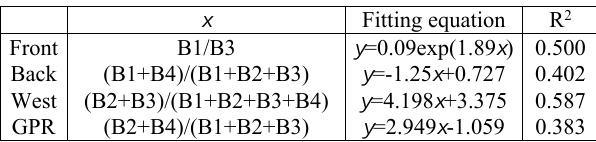
Table 5. The ag440 regression models of GPR channels based on GF-1 PMS band setting